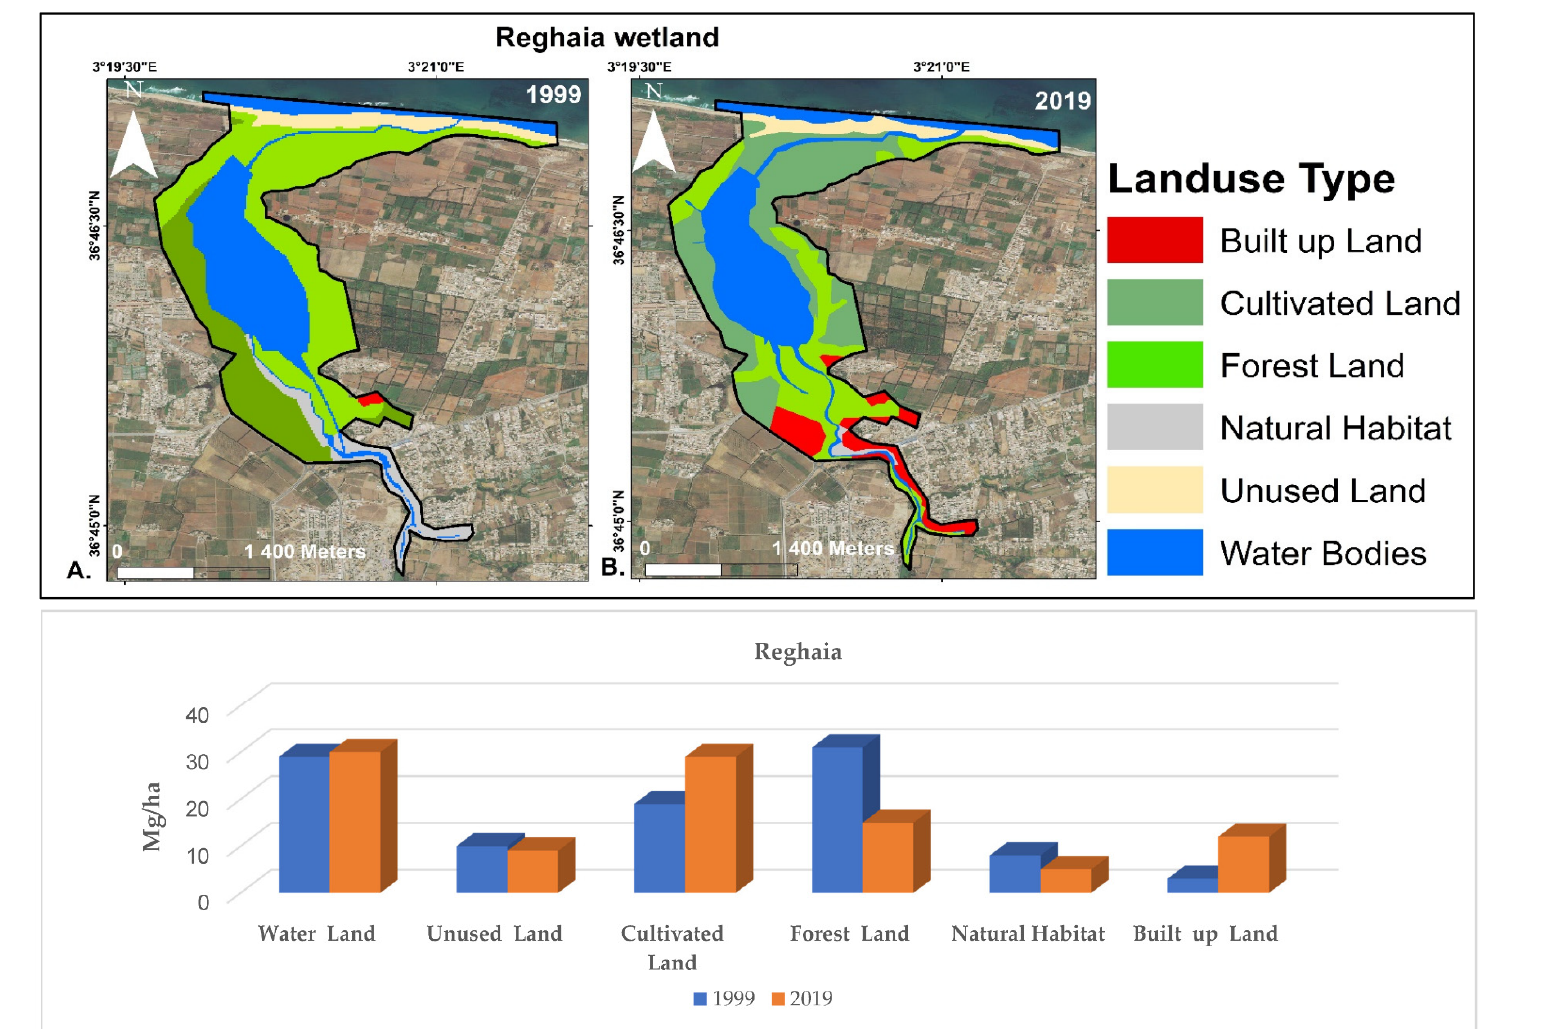
Figure 7. Maps and percentages of LULC changes in Reghaia between 1999 and 2019: ( A ) LULC change of 1999; ( B ) LULC change of 2019 .